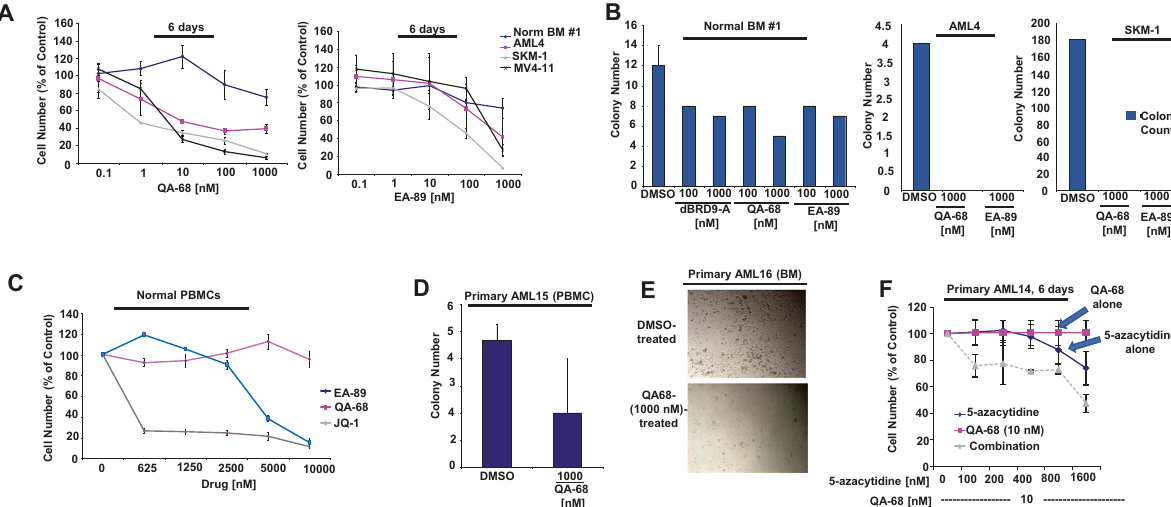
Fig. 5 Targeted loss of BRD9 protein by degradation leads to inhibition of primary AML and ALL cell growth and colony formation. A Proliferation assays: Normal bone marrow cells (sample #1) and primary AML4 cells (secondary AML) treated with QA-68 and EA-89. 6-day assay. SKM-1 and MV4-11 cell lines were tested as positive controls ( B ) QA-68, EA-89 and dBRD9-A effects on normal bone marrow or primary AML4 colony formation using MethoCult H4434 Classic methylcellulose medium (with cytokines) and IMDM culture media. SKM-1 cells were tested as a positive control. Shown are colony counts taken following 8 days from the start of the assay. C Treatment of normal PBMCs with QA-68 or EA-89 versus the BRD4 inhibitor, JQ1. 4-day assay. D Effects of QA-68 treatment on primary AML PBMCs (sample AML15) colony formation, using MethoCult Enriched H4435 methylcellulose medium and IMDM culture media. Shown are colony counts taken following 12 days from the start of the assay. E Effects of QA-68 treatment on primary AML patient BM cells (sample AML16) colony formation, using alone, 5-azacytidine alone, or a combination. 6-day